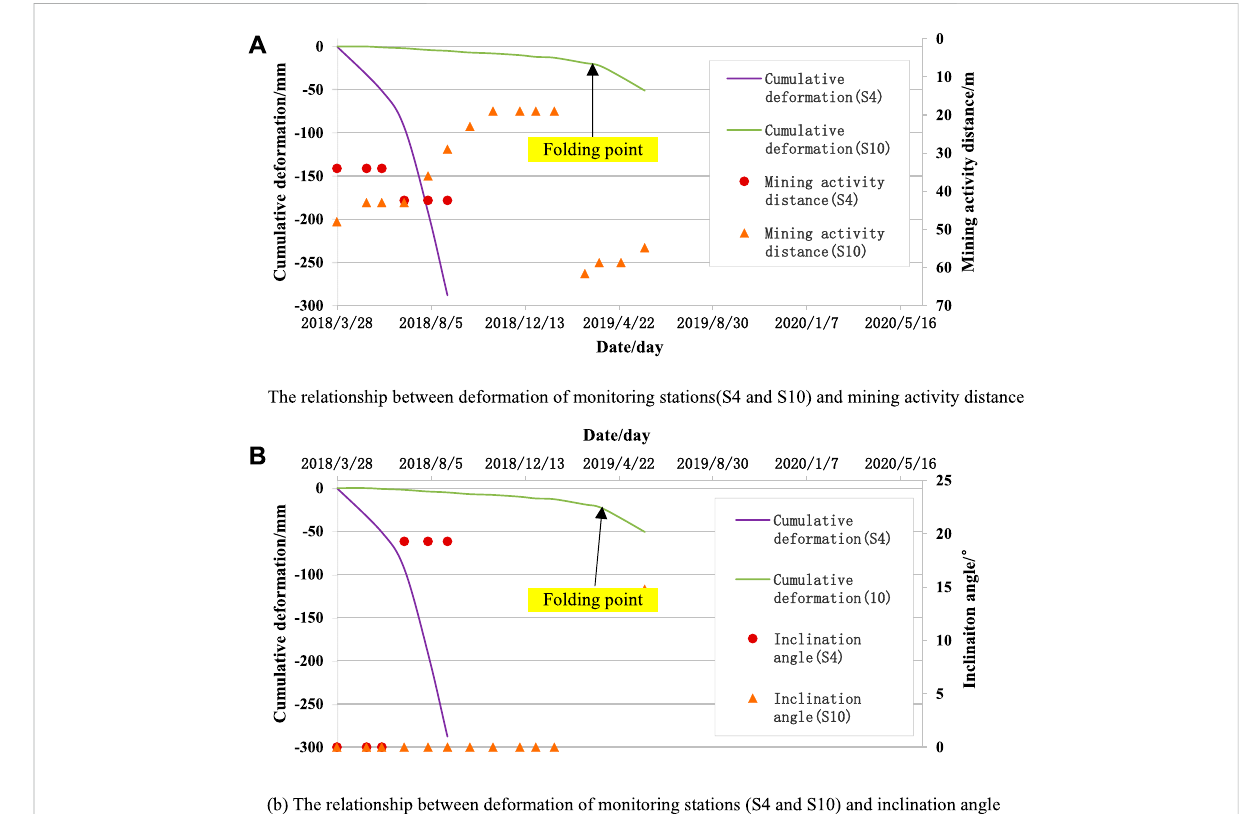
FIGURE 10 Relationship between deformation of monitoring stations (S4 and S10) and mining under polar coordination system. (A) The relationship between deformation of monitoring stations (S4 and S10) and mining activity distance. (B) The relationship between deformation of monitoring stations (S4 and S10) and inclination angle.